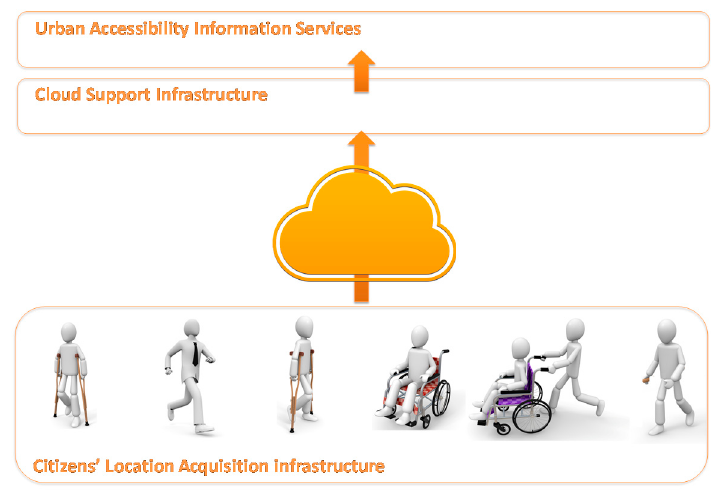
Figure 1. Overall architecture of the System for Accessibility Monitoring in Smart Cities.